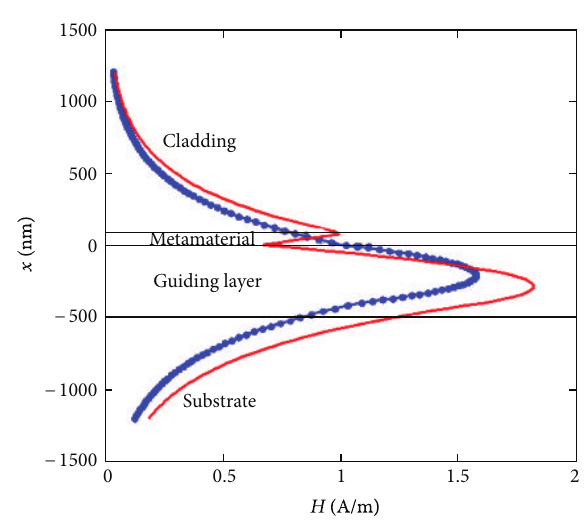
Figure 2: Magnetic field 𝐻 𝑦 (𝑥) distribution in the conventional pla- nar waveguide sensor (blue dotted line) and metamaterials assisted planar waveguide sensor (red line), and 𝑑 2 is the thickness of the metamaterials (red line)